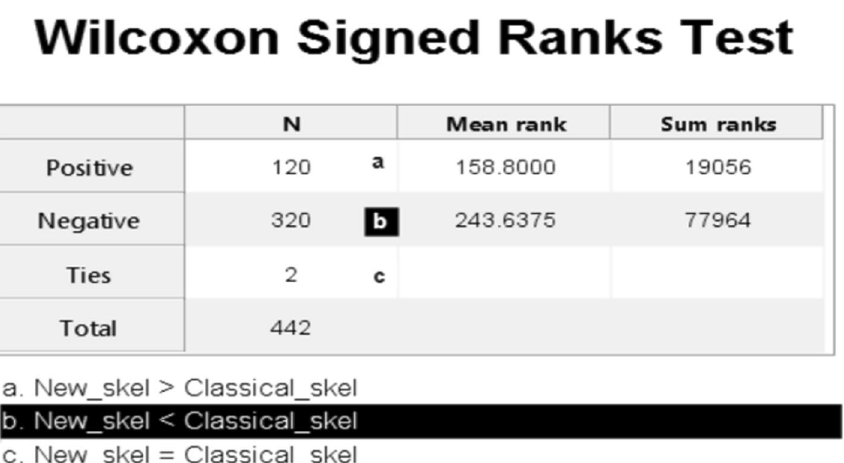
Figure 11. The Wilcoxon Signed Ranks Test for the mean-IoU data in Table 2. The graph obtained from the Wilcoxon Signed Ranks test using the Statistics and Machine Learning Toolbox of Matlab2018b. Statistical toolbox showed a negative ranges value that was higher than the positive ranges value. The p value of this test was 2.56E−28 less than the significance value. So we can conclude that a statistically significant difference appeared between both methods and that the proposed method (New_skel) indicated a significant improvement over the classic method